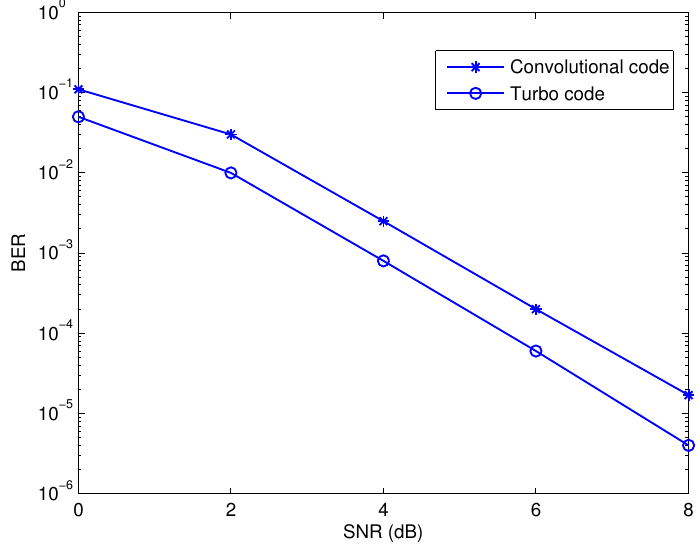
Figure 6. BER performance of the proposed approach at different codes.